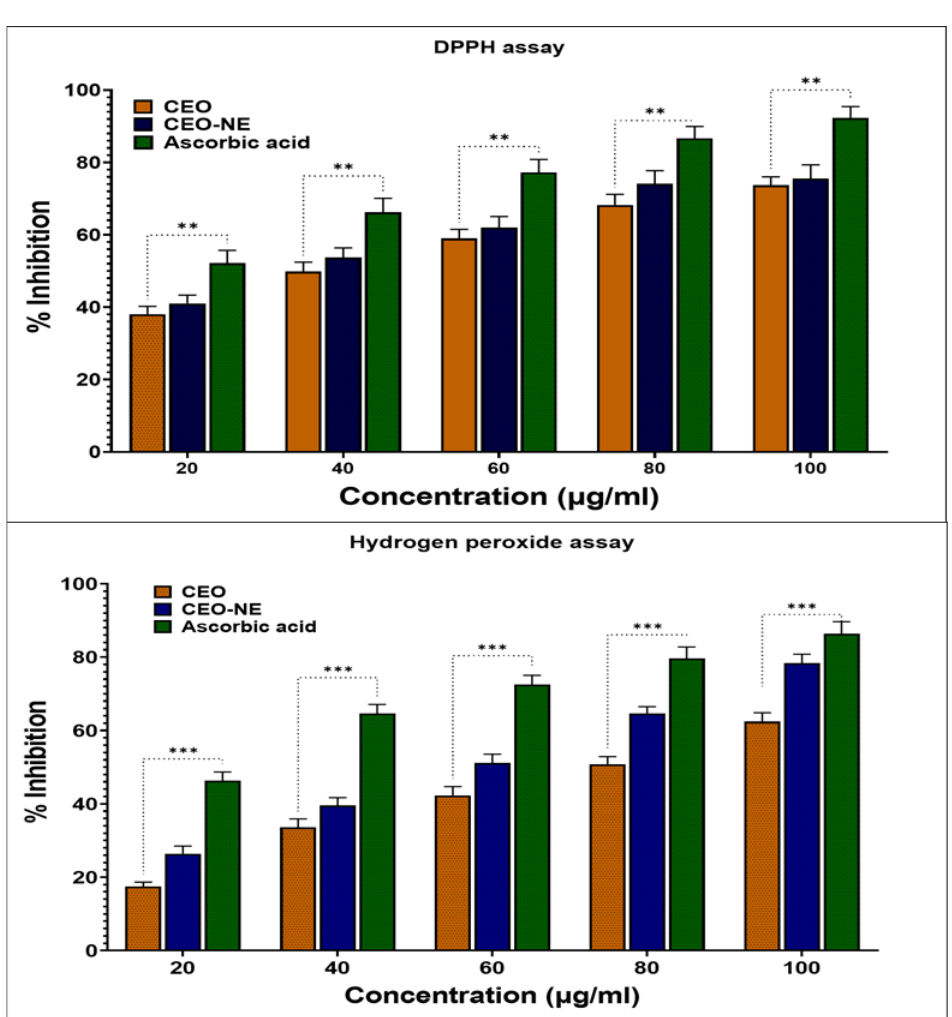
Figure 5. Comparative antioxidant activities: ( A ) DPPH radical scavenging assay of ascorbic acid, CEO, and CEO-NEO; ( B ) hydrogen peroxide assay of ascorbic acid, CEO, and CEO-NEO. p -value (** p < 0.01 and *** p < 0.001), when compared to a standard compound using two-way ANOVA of GraphPad prism 9.5.0.